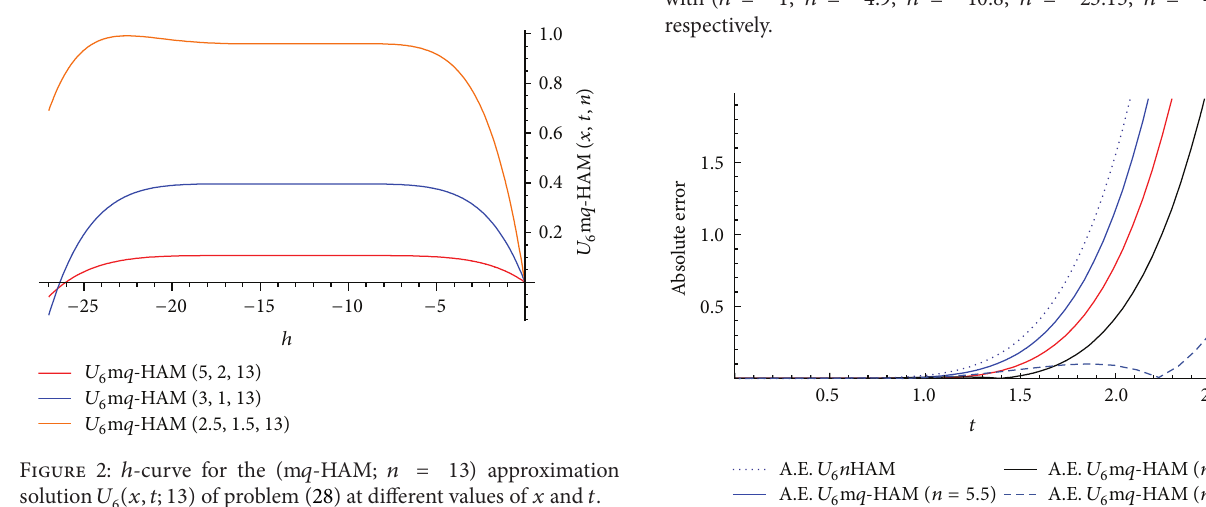
Figure 4: The absolute error of 𝑈 6 of 𝑛 HAM (m 𝑞 -HAM; 𝑛 = 1 ) and 𝑈 6 m 𝑞 -HAM (𝑛 = 5.5, 13, 30, 75) for problem (28) at 𝑥 = 1 using (ℎ = −1, ℎ = −4.9, ℎ = −10.8, ℎ = −23.15, ℎ = −49.25) ,